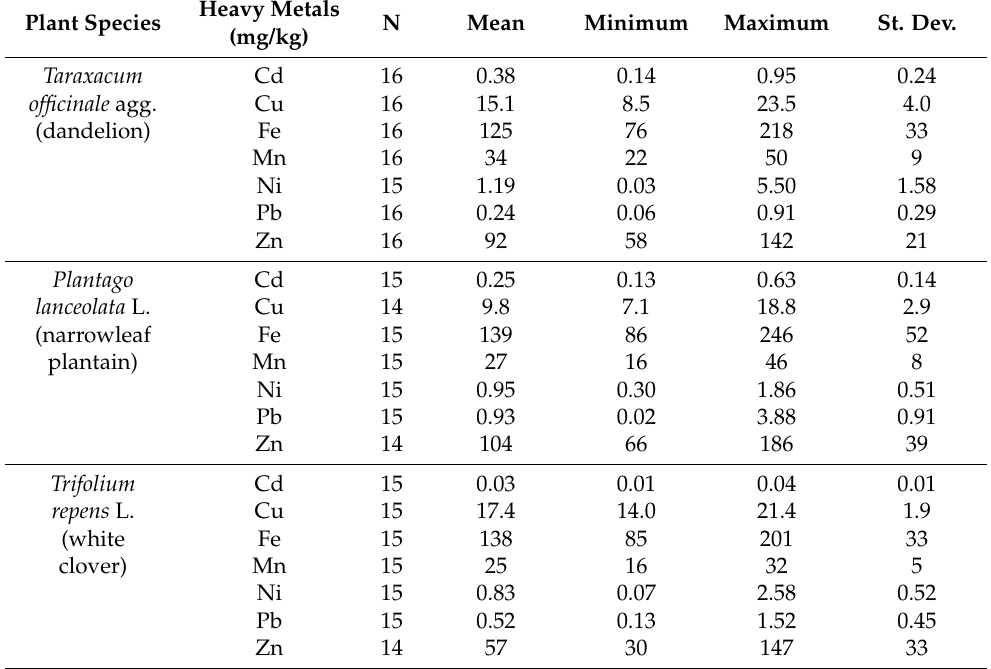
Table 2. Descriptive statistics of heavy metal content, expressed in mg/kg, in washed plant samples ( Taraxacum officinale , Plantago lanceolata and Trifolium repens ) of urban grassland in the city of Varaždin (Northern